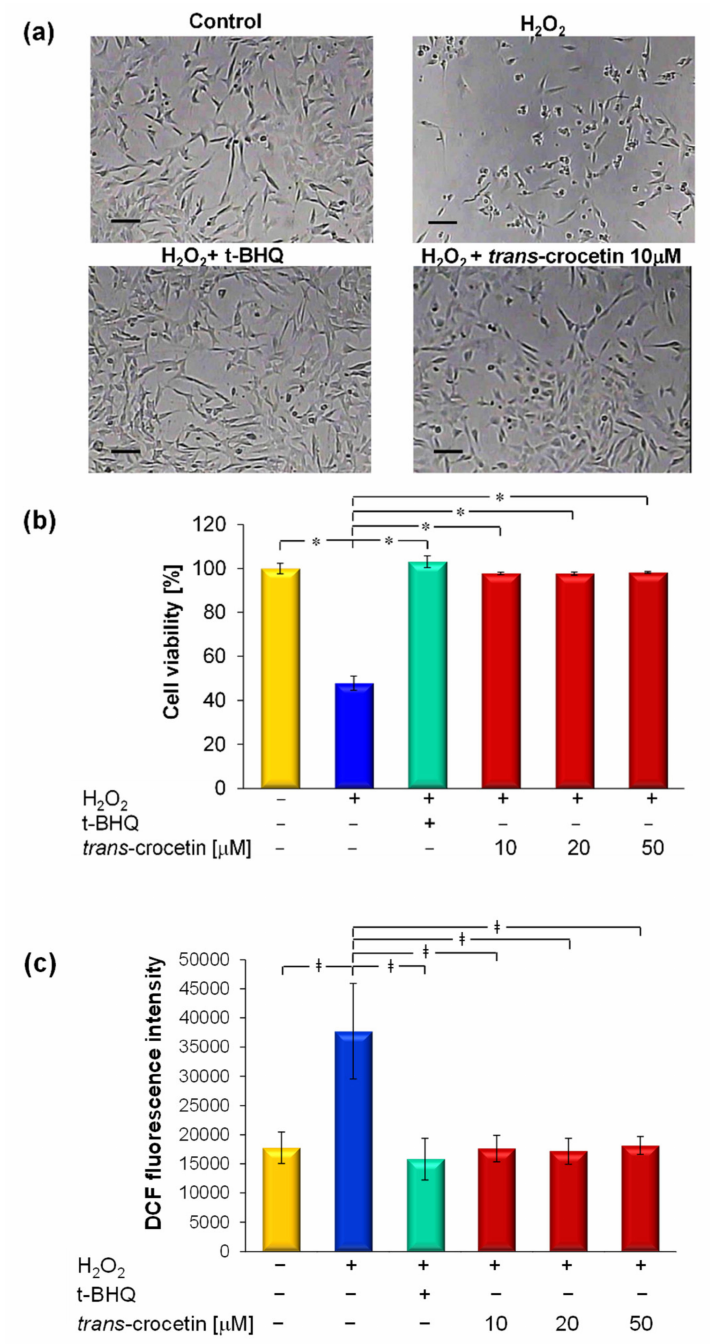
Figure 3. Trans-crocetin neuroprotective effect against H 2 O 2 -induced oxidative stress: ( a ) representa- tive images of neurons in the PLGA multiplex membrane system without any treatment (control), after 24 h of hydrogen peroxide insult (H 2 O 2 ), co-treatment with ter-butyldroquinone (t-BHQ) (H 2 O 2 + t-BHQ) and trans-crocetin (10 µ M) (H 2 O 2 + trans-crocetin); ( b ) cell viability and ( c ) intracel- lular oxygen reactive species(ROS) levels, calculated by quantitative analysis of Dichlorofluorescein (DCF) fluorescence intensity, in neuronal cells under different treatments. The antioxidant tBHQ was used as a positive control. The values expressed as average ± SD are the means of three experiments, and statistically significant data were evaluated according to an ANOVA followed by a Bonferroni t -test ( p < 0.05). * vs. H 2 O 2 insult, vs. other